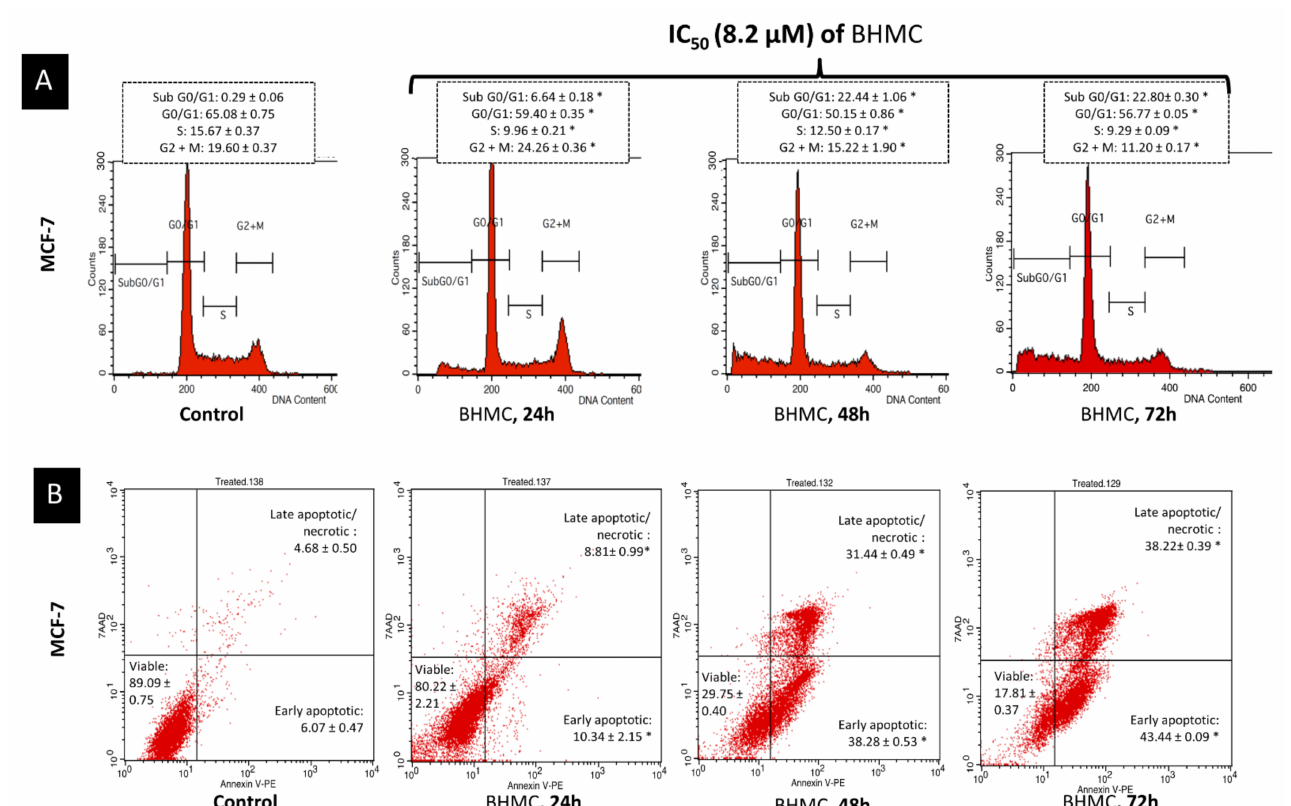
Figure 2. DK2 induces apoptosis in MCF 7 cells via G1/S cell cycle arrest. ( A ) Histogram analysis of the cell cycle machinery in MCF-7 after BHMC treatment for 24, 48, and 72 h. ( B ) Detection of phosphatidylserine (PS) exposure through the detection of Annexin V-PE and 7ADD fluorescence uptake in BHMC treated MCF-7 cells. Note: Values are mean ± SD of three replicates and significantly different from the untreated group (* p < 0.05) by ANOVA and followed by Duncan’s multiple range test. Figures shown are representative of one of at least three independent replicates with similar